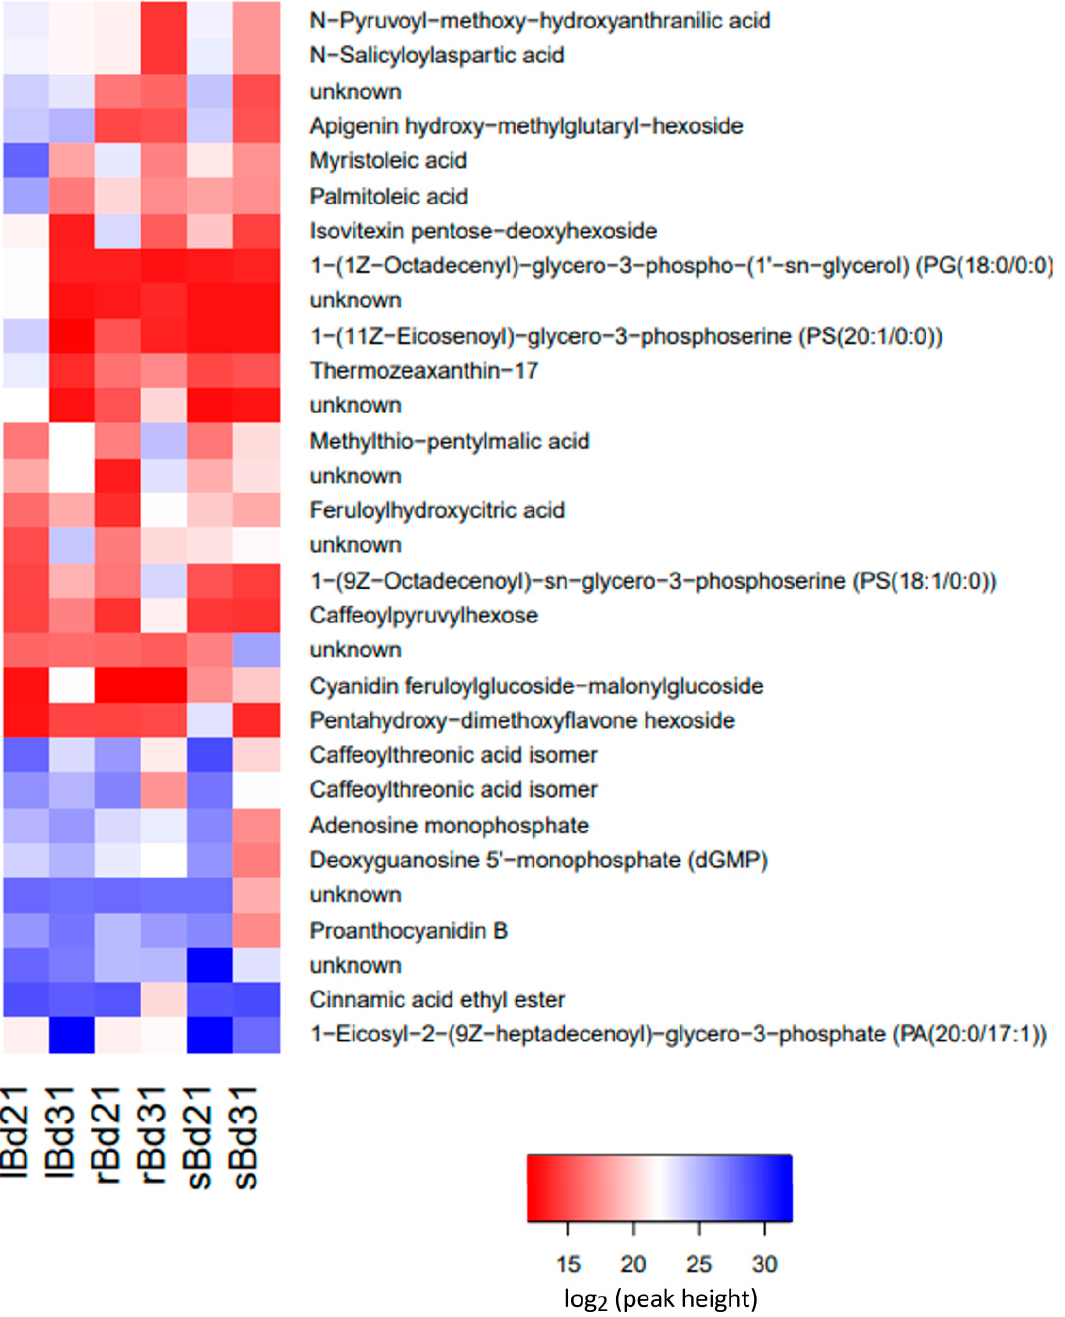
Figure 3. Abundances of peaks representing selected MS signals highly differentiated Brachypodium lines in particular organs. Colour scale presents log 2 from respective peak heights. Tentative signal annotations based on O. sativa metabolic database from Kyoto Encyclopedia of Genes and Genomes (KEGG) [35,37]. l—leaves; r—roots; s—spikes.